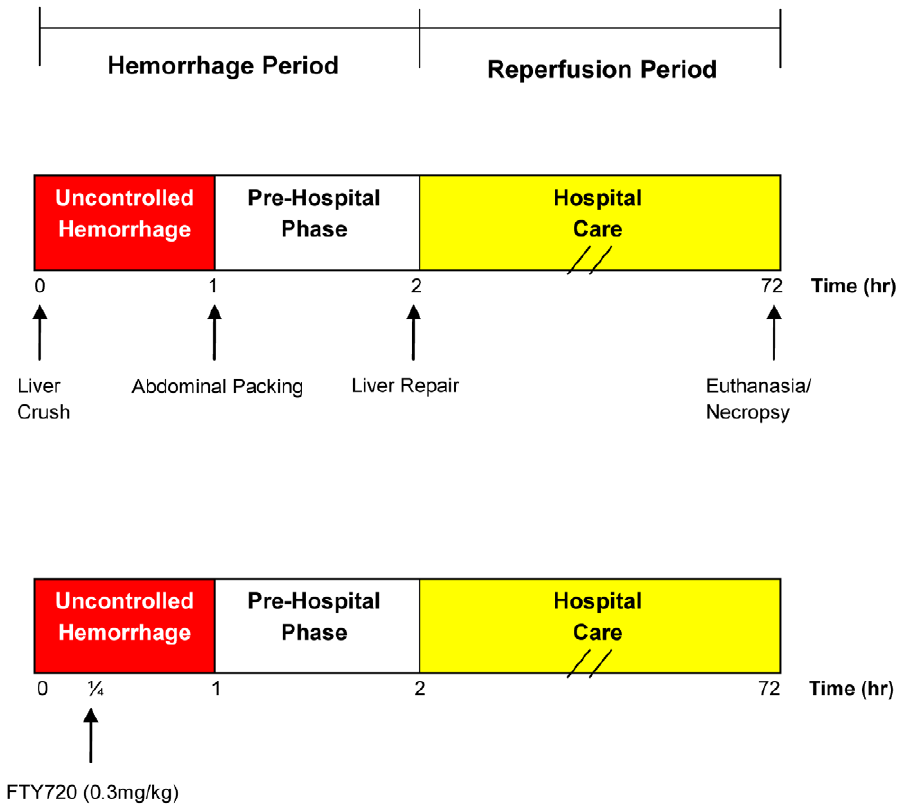
Figure 1. Experimental design. Liver injury was initiated at t=0. Uncontrolled hemorrhage occurred until 1 hour, at which time the abdomen was packed and temporarily closed (pre-hospital phase). The animal was observed until 2 hours when hospital care was initiated. The liver was repaired and the abdomen definitively closed. The animal was then observed for a total of 72 hours. Blood transfusion was administered as indicated. Necropsy was performed when the animal expired or at 72 hours following euthanasia. The uncontrolled hemorrhage and pre-hospital phases were considered the hemorrhage period, while the hospital care phase was considered the reperfusion period. In the experimental group, FTY720 (0.3 mg/ kg diluted in 250 mL of NS)) was administered 15 minutes following liver injury. Vehicle controls were treated with 250 mL of NS. 1:50 and incubated overnight at 4C. Biotinylated goat anti-rat IgG specific polyclonal antibody (BD Biosciences, San Jose, CA) was